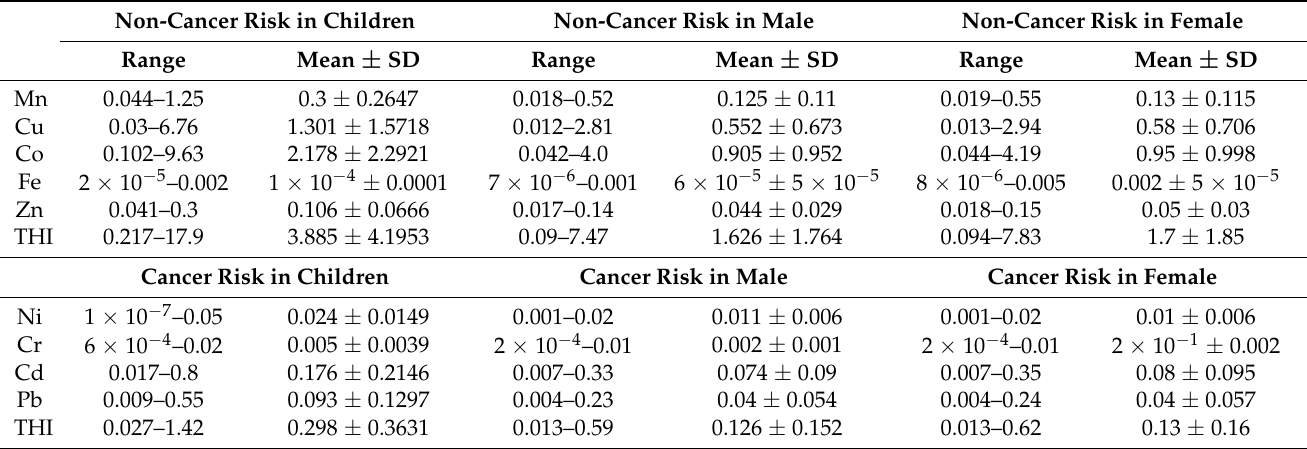
Table 4. Describe the non-cancer risk and the cancer risk of PHE consumption through oral ingestion of groundwater from the Adenzai flood plain region of